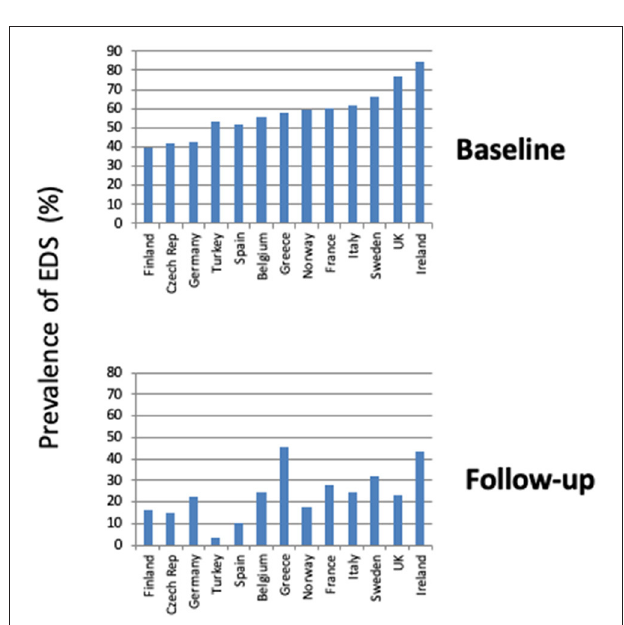
FIGURE 6 | Prevalence of EDS at baseline and first follow-up visit in different ESADA countries in entire sample. Only countries reporting data on at least 50 patients are